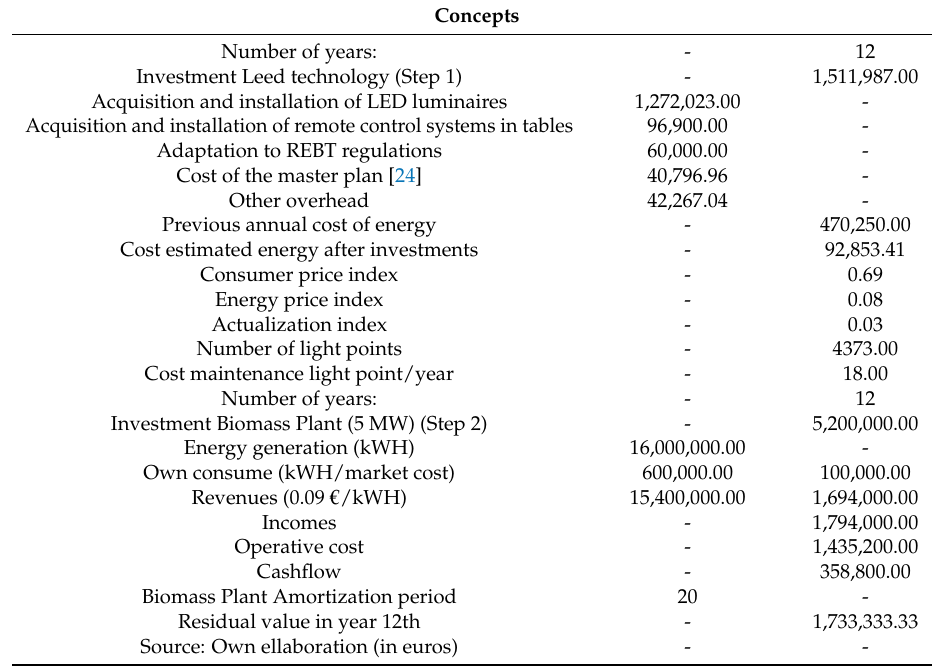
Table 3. Project information.